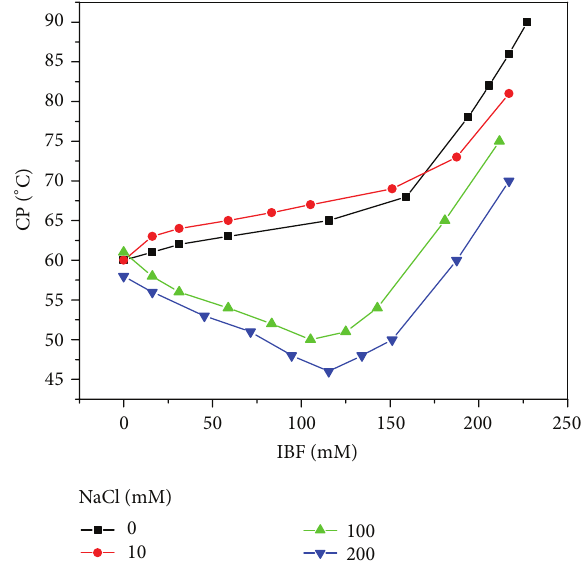
Figure 2: Effect of various concentrations of NaCl on the CP of the NORT-HPMC system.